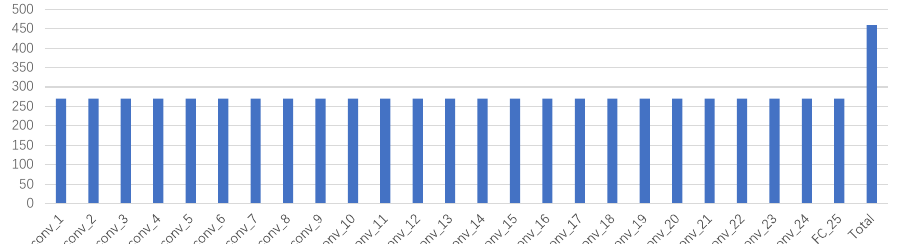
Figure 10. The latency of each layer and total network.